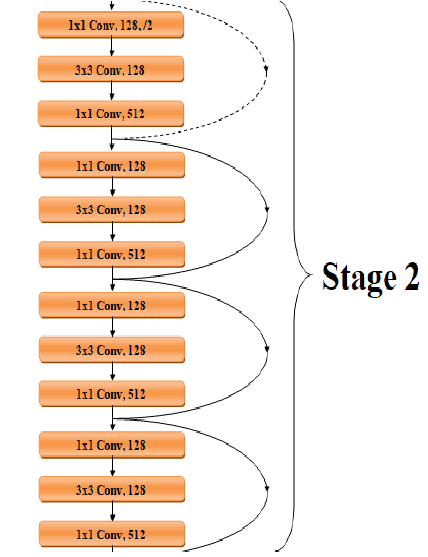
Figure 7. Stage 2 Architecture of